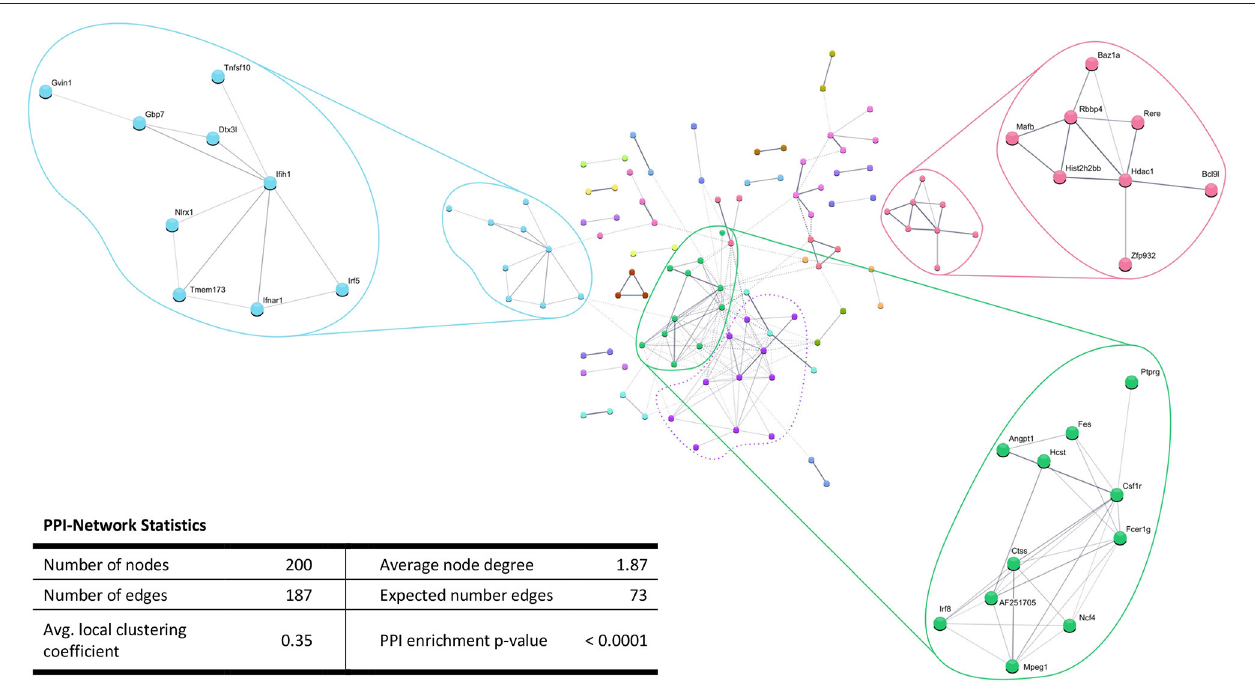
FIGURE 5 | STRING database protein-protein interaction (PPI) networks of significantly downregulated genes. Cut-off values, p ≤ 0.01, fold change ≥ 1.2. Cluster analysis revealed four clusters of interacting proteins, of which one (purple cluster) did not show significantly enriched pathways and